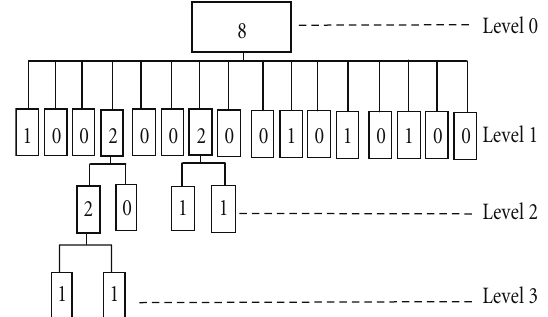
Figure 4: Hierarchy of cutting that represents the classification space in Figure